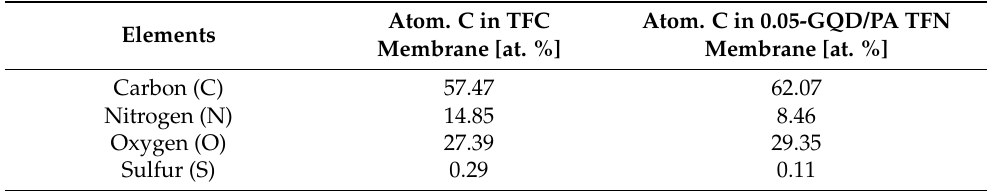
Table 3. Elemental compositional analysis of the TFC and 0.05-GQD/PA TFN membranes.